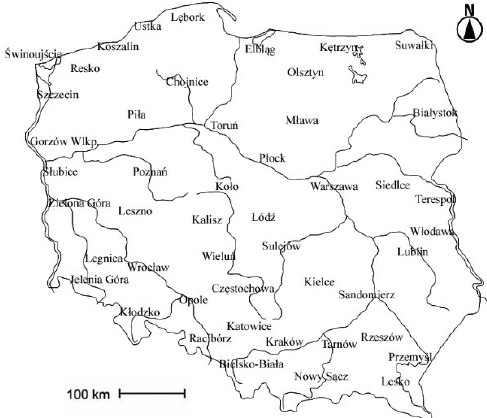
Figure 1. Distribution of weather stations in Poland.